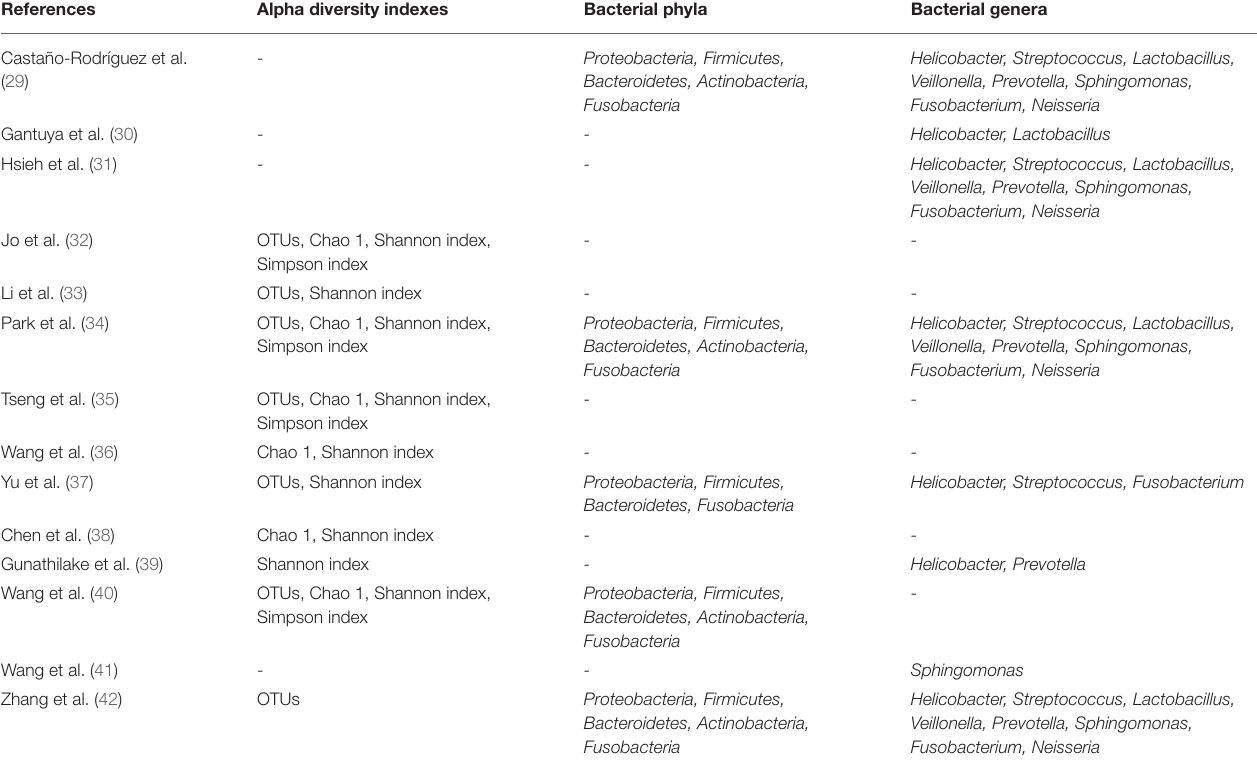
TABLE 2 | Phenomenon of interest reported by included